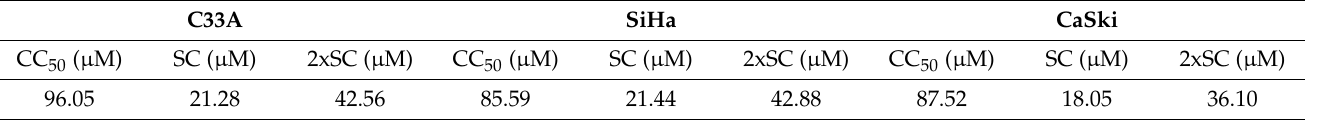
Table 1. The CC50 a , SC b and 2xSC of Androg on cervical cancer cell lines. C33A SiHa